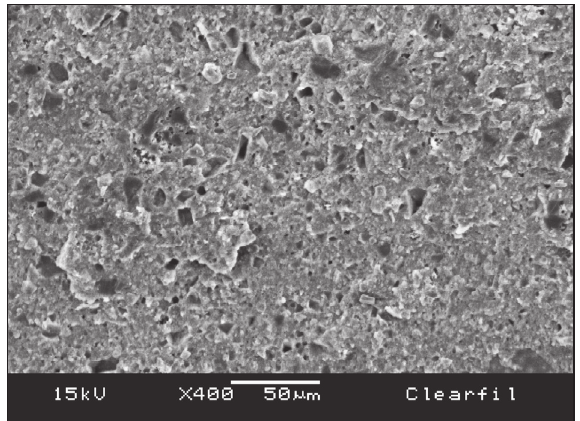
Figure 3 - Adhesive failure along the pre-polymerized com- posite overlay interface showing little signs of the RelyX Uni- cem cement (type 2; original magnification 400 ×